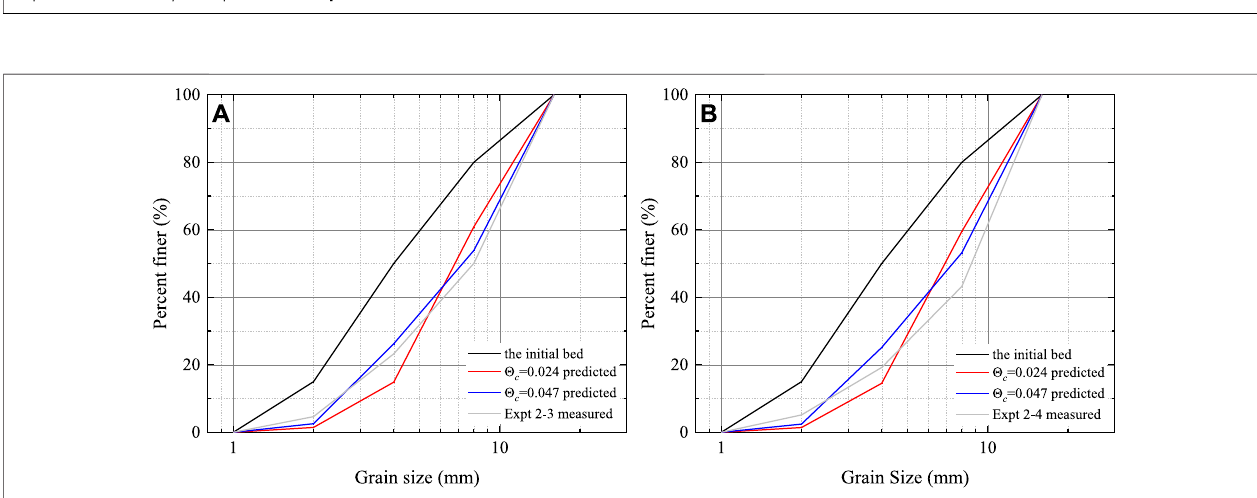
FIGURE 4| Plot of Eq. 10 , showing the correlation between D Church, (2000), the open fi ve-point stars represent HM7-HM9 Hassan and Church, (2000), and the crosses represent data from (Church et al., 1998). The open circles represent values of q p computed from Eq. 10 for our data.